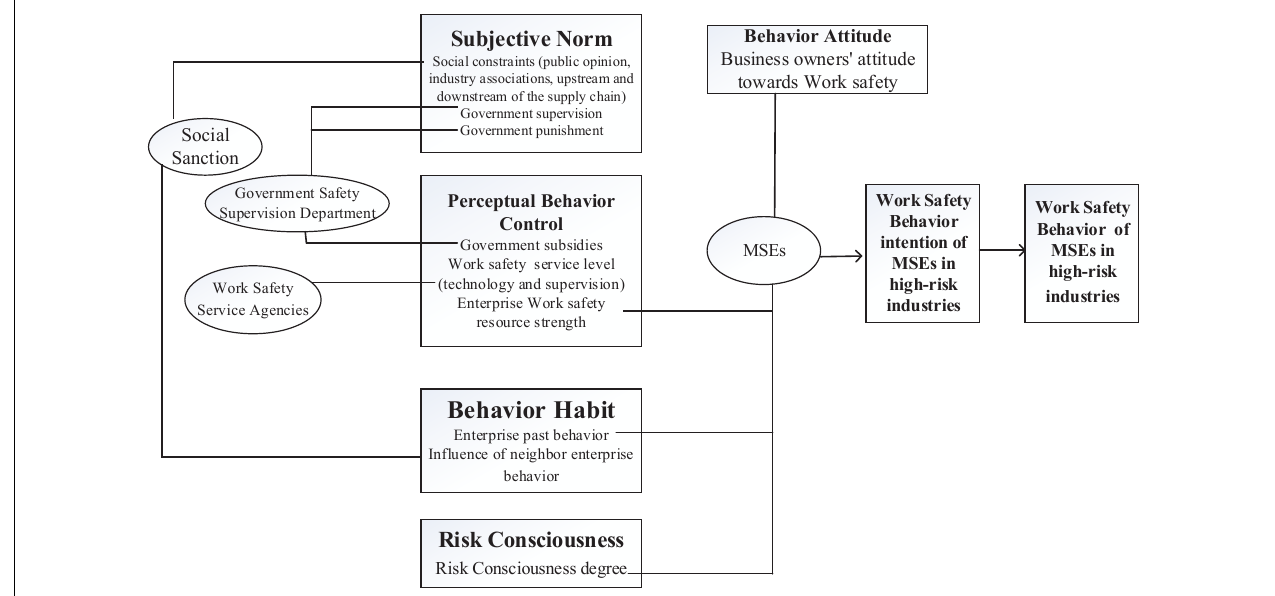
FIGURE 4 | Influence mechanism of work safety behaviors of MSEs in high-risk